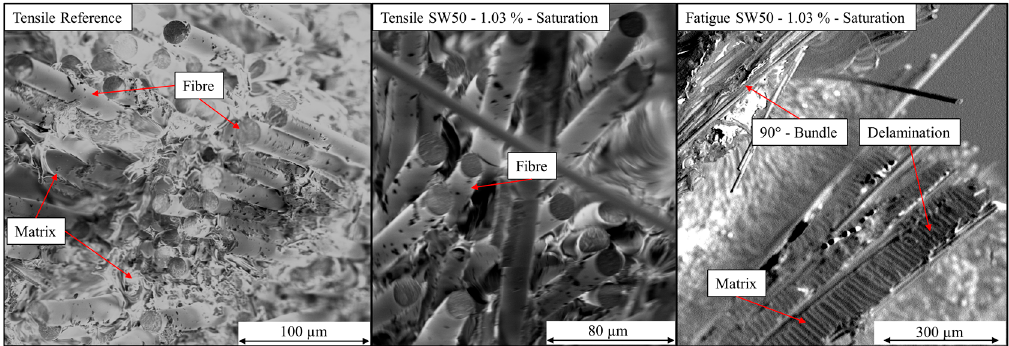
Figure 12. Scanning electron microscopy (SEM) photograph of fracture surfaces of the tensile specimens in dry (left) and saturated (middle) conditions, as well as the fatigue fracture surface in saturated condition (right).